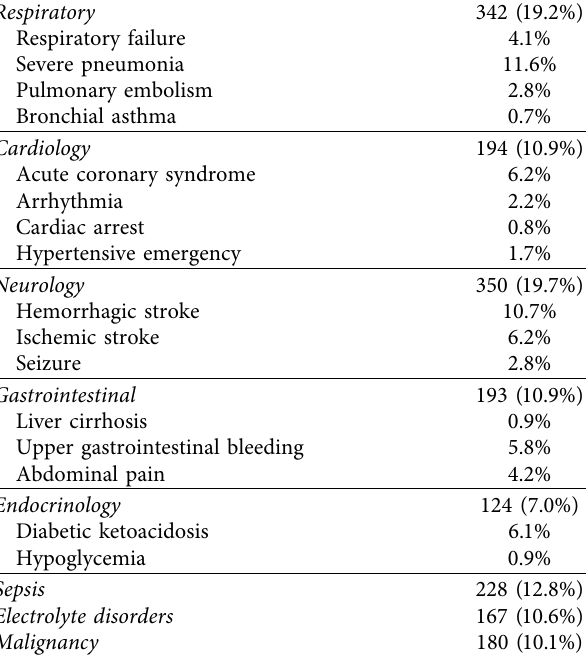
Table 2: Major causes of admission.